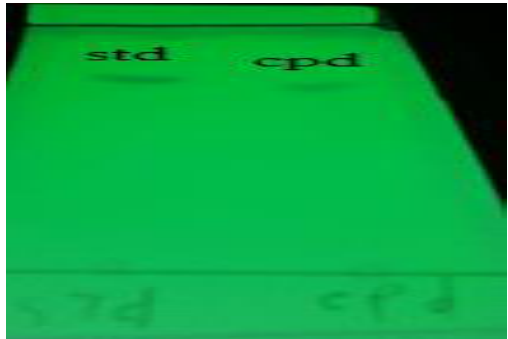
Figure 13. TLC chromatography for isolatede compound number (3) from ethyl acetate